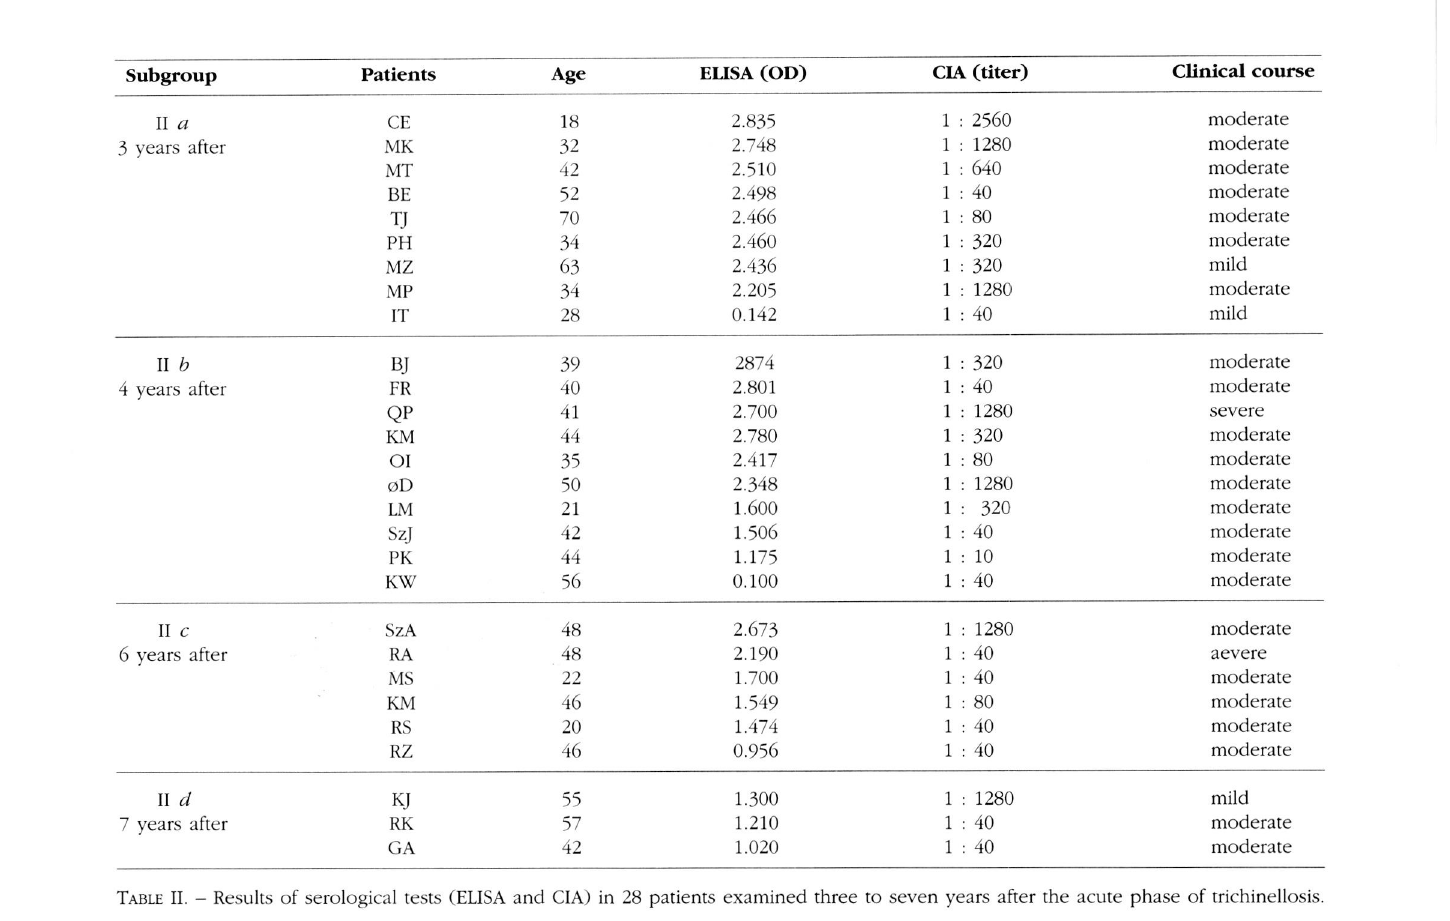
(Group I) the high ELISA valu.es, noted in 80 % patients, were confirmed only in 46.6 % of patients, using the CIA test. On the other hand, most of patients in Group II (subgroups a and b), examined three and four years, respectively, after acute trichinellosis had still high OD with ELISA whereas high CIA titres were noted in only 30-33 % cases. This observation could indicate a lower specificity of the ELISA compared to the CIA test. The latter correlated with parasitological testing of muscle biopsies, which documented few Tri-